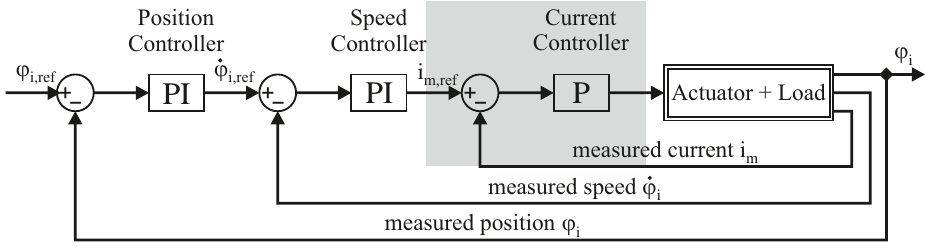
Figure 6. Schematic diagram of the experimental setup using the four actuators. The index i represents the description of the actuator under consideration (hip/knee,